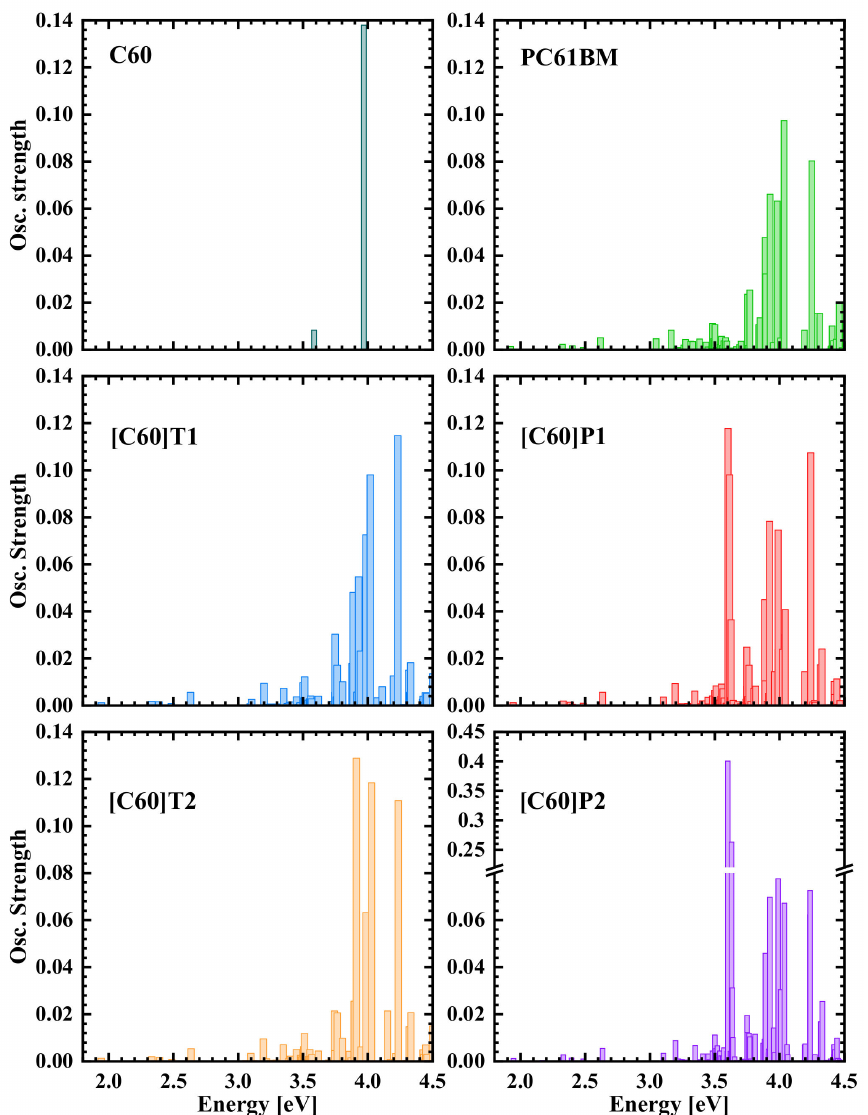
Figure 4. Calculated oscillatory strength of optical transitions for the studied fullerene derivatives and C60 molecule. Note the broken scale in the ordinate axis for the [C60]P2 spectrum (strong intra-pyrene